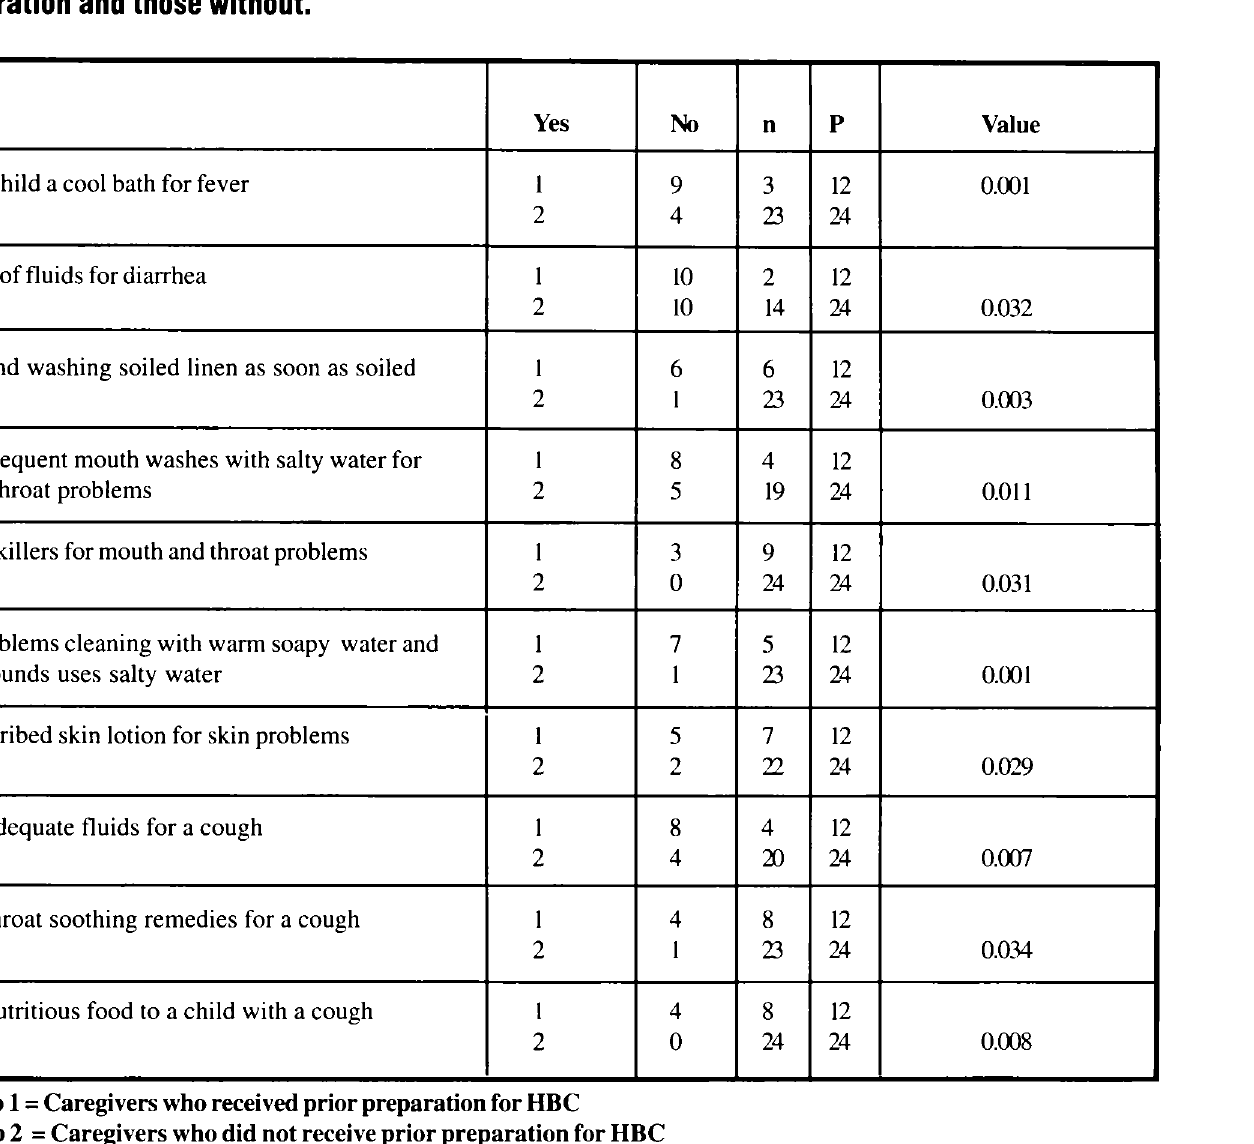
Table 5: Fishers’ exact two-tail test analysis on specific areas of knowledge between care givers with prior preparation and those